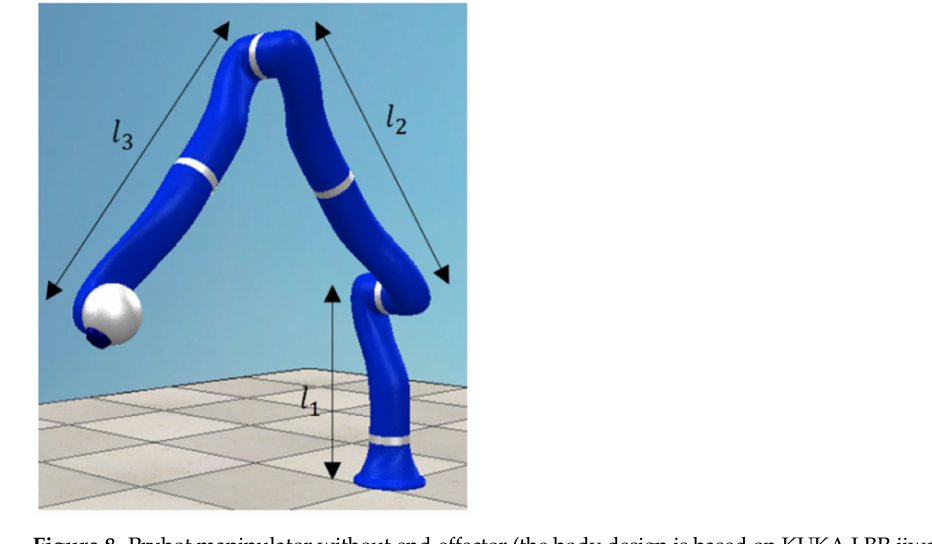
Figure 8. Prubot manipulator without end-effector (the body design is based on KUKA LBR iiwa